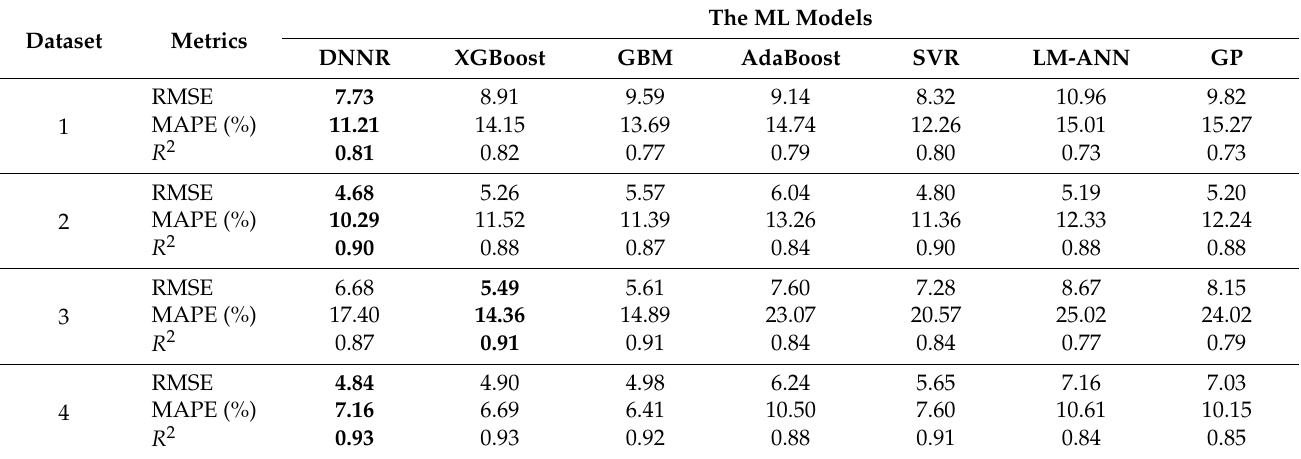
Table 6. Average performance of the ML